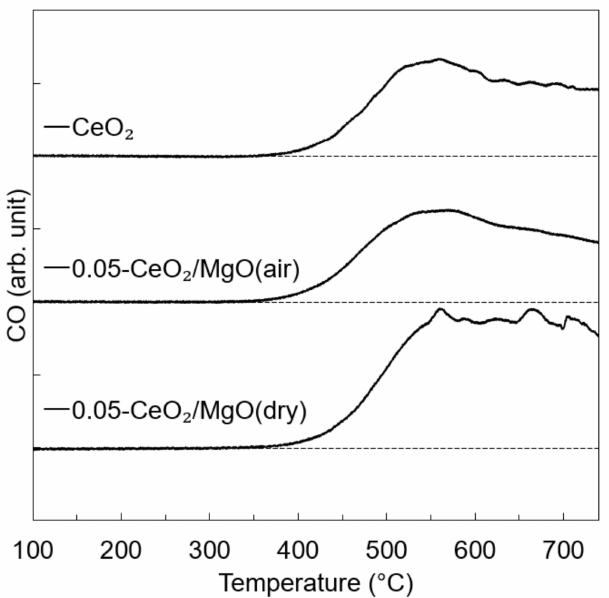
Figure 5. CO 2 -TPO profiles of the reduced catalysts. The catalysts were heated at 20 ◦ C/min in a 5% CO 2 /Ar flow after the reduction at 550 ◦ C in a 5% H 2 /Ar